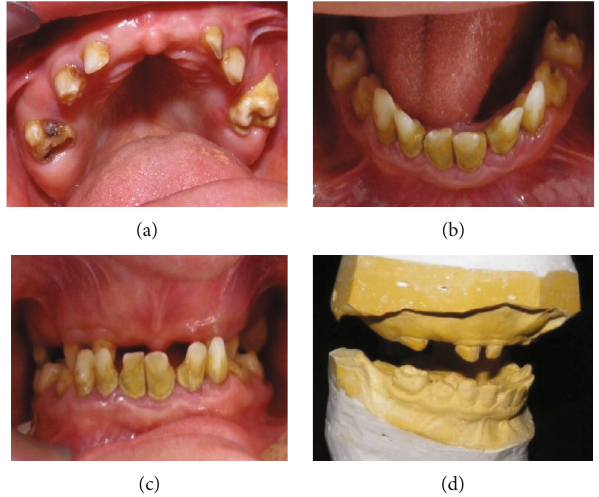
Figure 2: Clinical evaluation. (a) Occlusal view of maxillary arch. (b) Occlusal view of mandibular arch. (c) Intraoral photograph showing an anterior and posterior cross bite. (d) Bite registration in the correct occlusal vertical